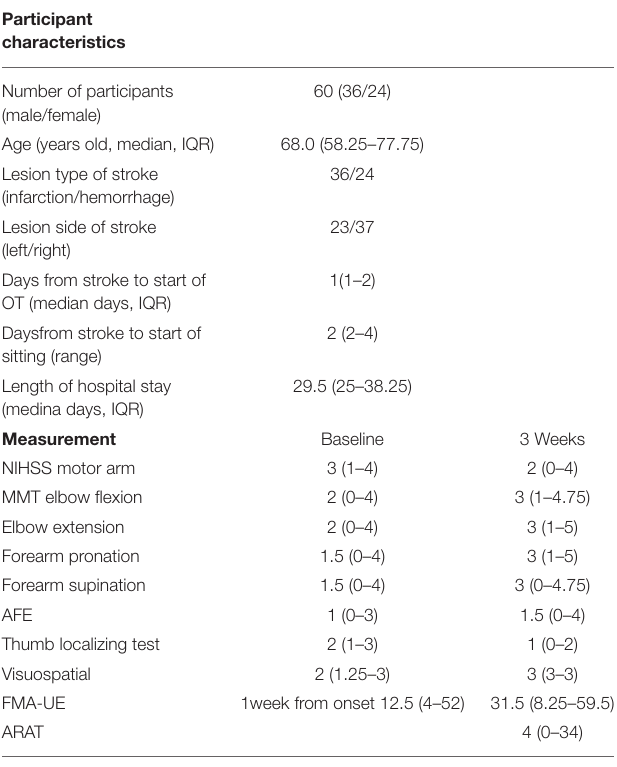
TABLE 2 | Participant Characteristics. Participant